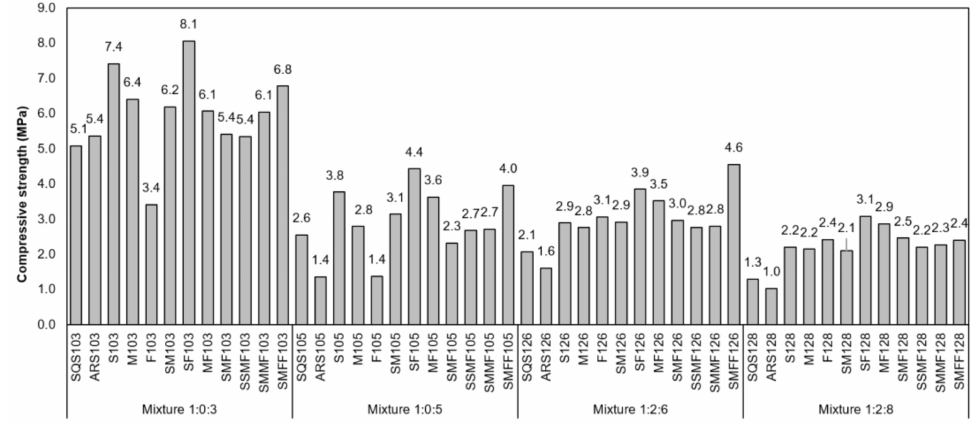
Figure 9. Compressive strength of the